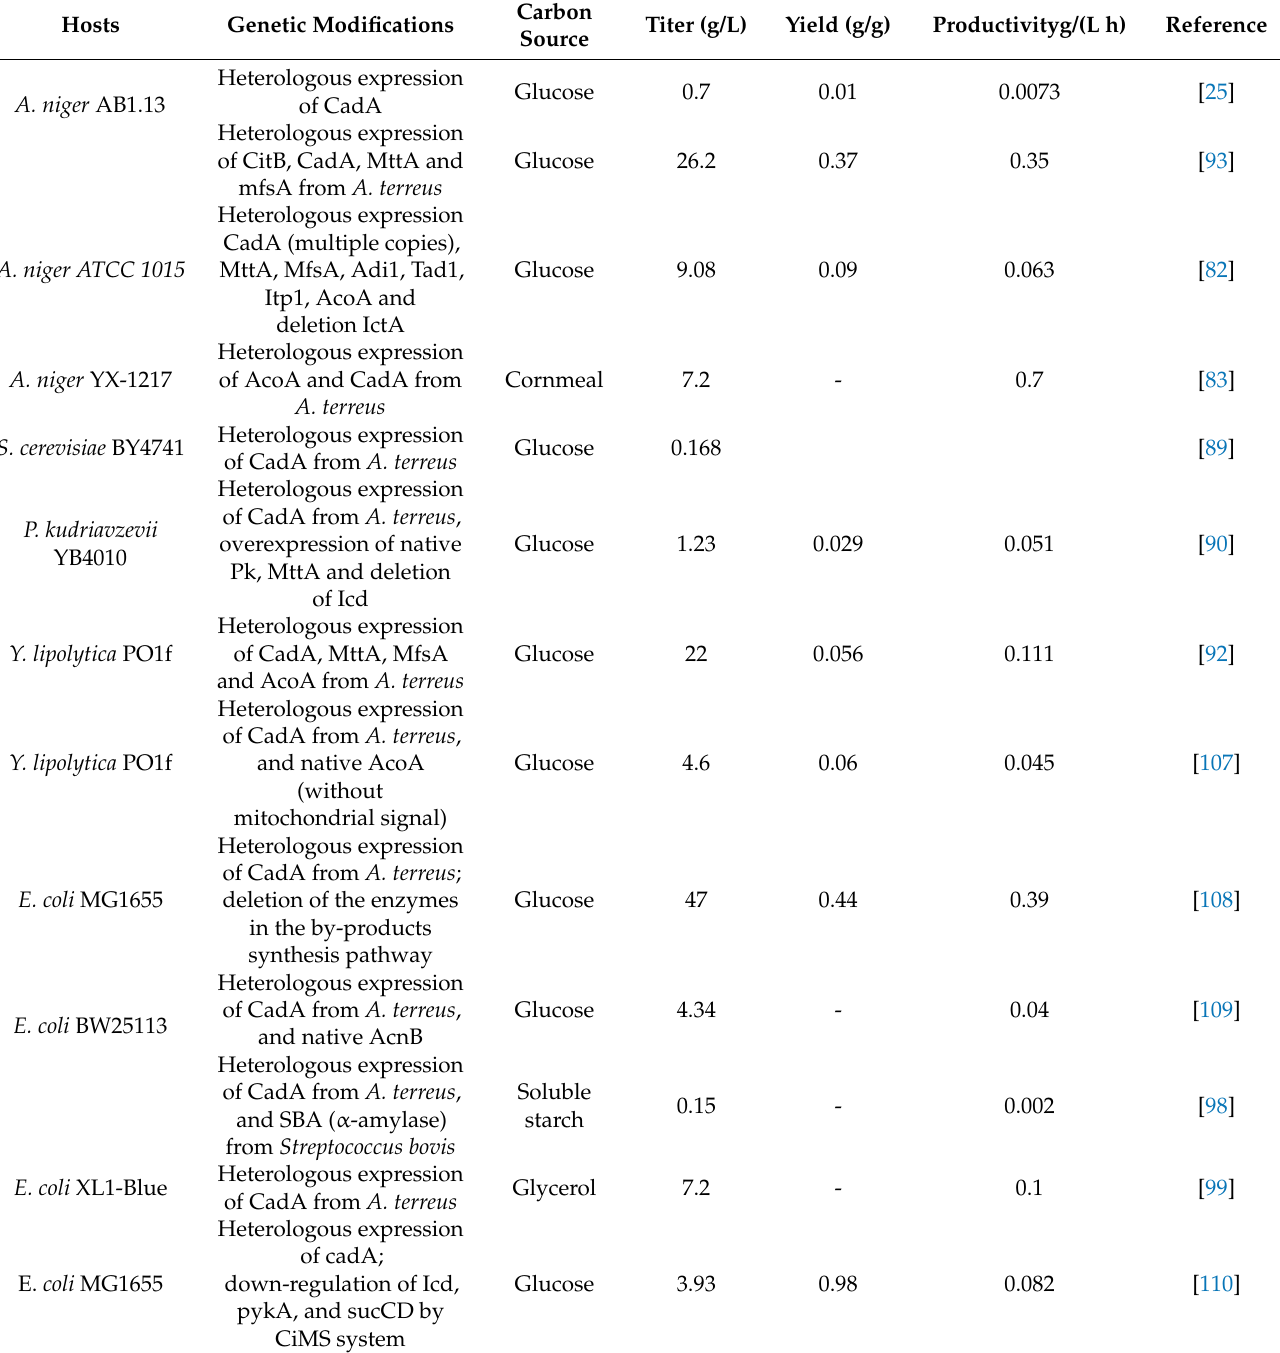
Table 2. Genetic engineering of model host for ITA